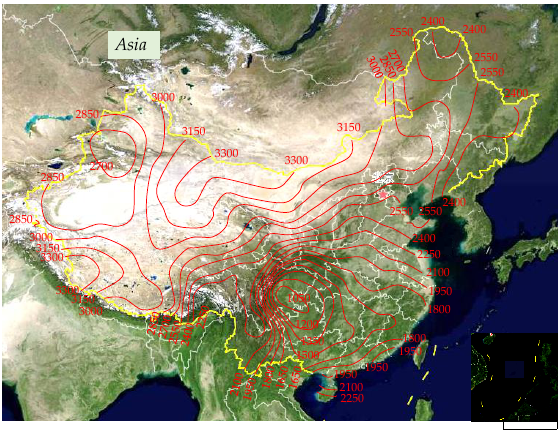
Figure 1. Distribution of annual average sunshine duration (h) in China from 1990 to 2020 [42,43]. The region with the shortest sunshine duration in China is in the Sichuan Basin, and the region with the longest sunshine duration is in the Qinghai–Tibet Plateau. The sunshine duration in the east is generally shorter than that in the northwest, but the sunshine duration is not equal to the distribution of solar energy resources and is also related to the climate conditions, such as cloud thickness. Figure 2 shows the distribution of annual total solar radiation in China in the most recent 30 years